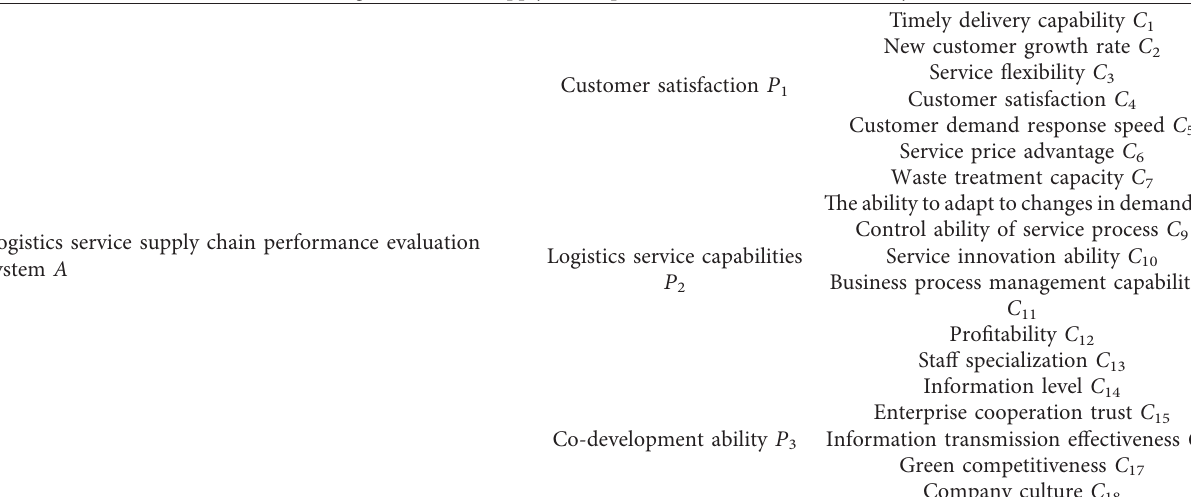
Figure 1: The design idea of the performance evaluation index system of logistics service supply chain. Table 1: Logistics service supply chain performance evaluation index